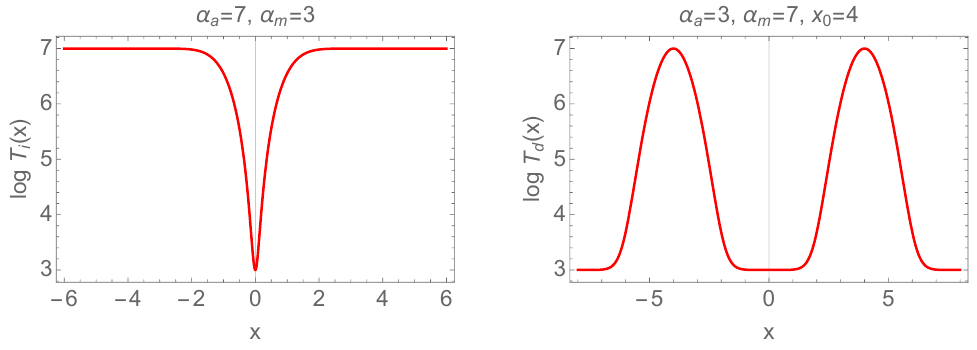
Figure 12 . The inverted gaussian and double gaussian initial conditions for typical values of α a , α m and x 0